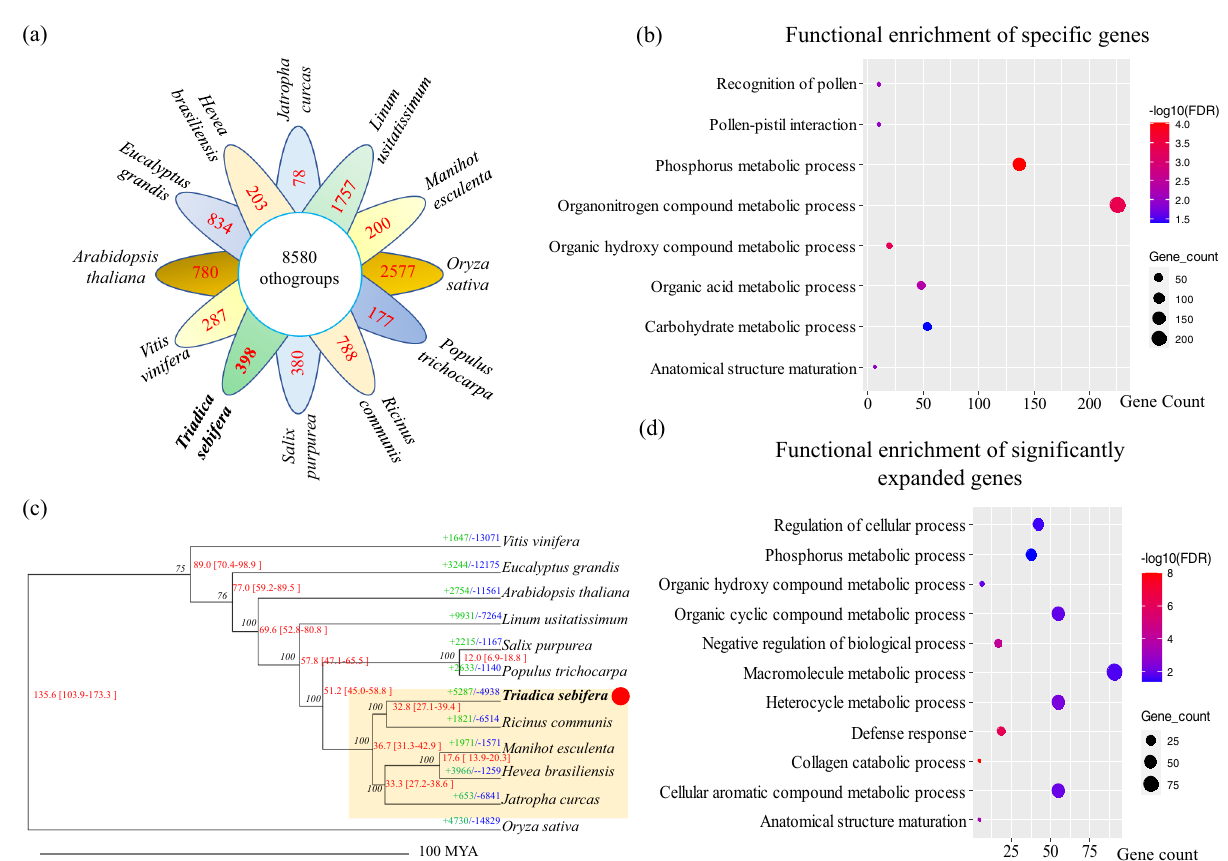
Fig. 2 Genome expansion and phylogenetic analyses for the Chinese tallow tree (CTT). a Orthogroups in the 12 plants, namely, CTT, Arabidopsis thaliana , Eucalyptus grandis , Hevea brasiliensis , Jatropha curcas , Linum usitatissimum , Manihot esculenta , Oryza sativa , Populus trichocarpa , Ricinus communis , Salix purpurea , and Vitis vinifera . b Functional enrichment of speci fi c genes in the CTT genome. FDR represents the false discovery rate. c Phylogenetic tree for 12 plants listed in a . Single-copy genes were used to construct this tree with the PROTGAMMAAUTO model in RAxML. “ + ” and “ − ” indicates gene expansion and contraction, respectively. The green and blue numbers indicate numbers of othogroups that expand or contract, respectively. The red numbers indicate divergent time. For example, 89.0 [70.4 – 98.9] indicates the average divergent time is 89.0 million years ago (MYA), and its 95% con fi dence interval is 70.4 to 98.9 MYA. Plants with yellow backgrounds belong to Euphorbiaceae family. d Functional enrichment of signi fi cantly expanded genes in the CTT